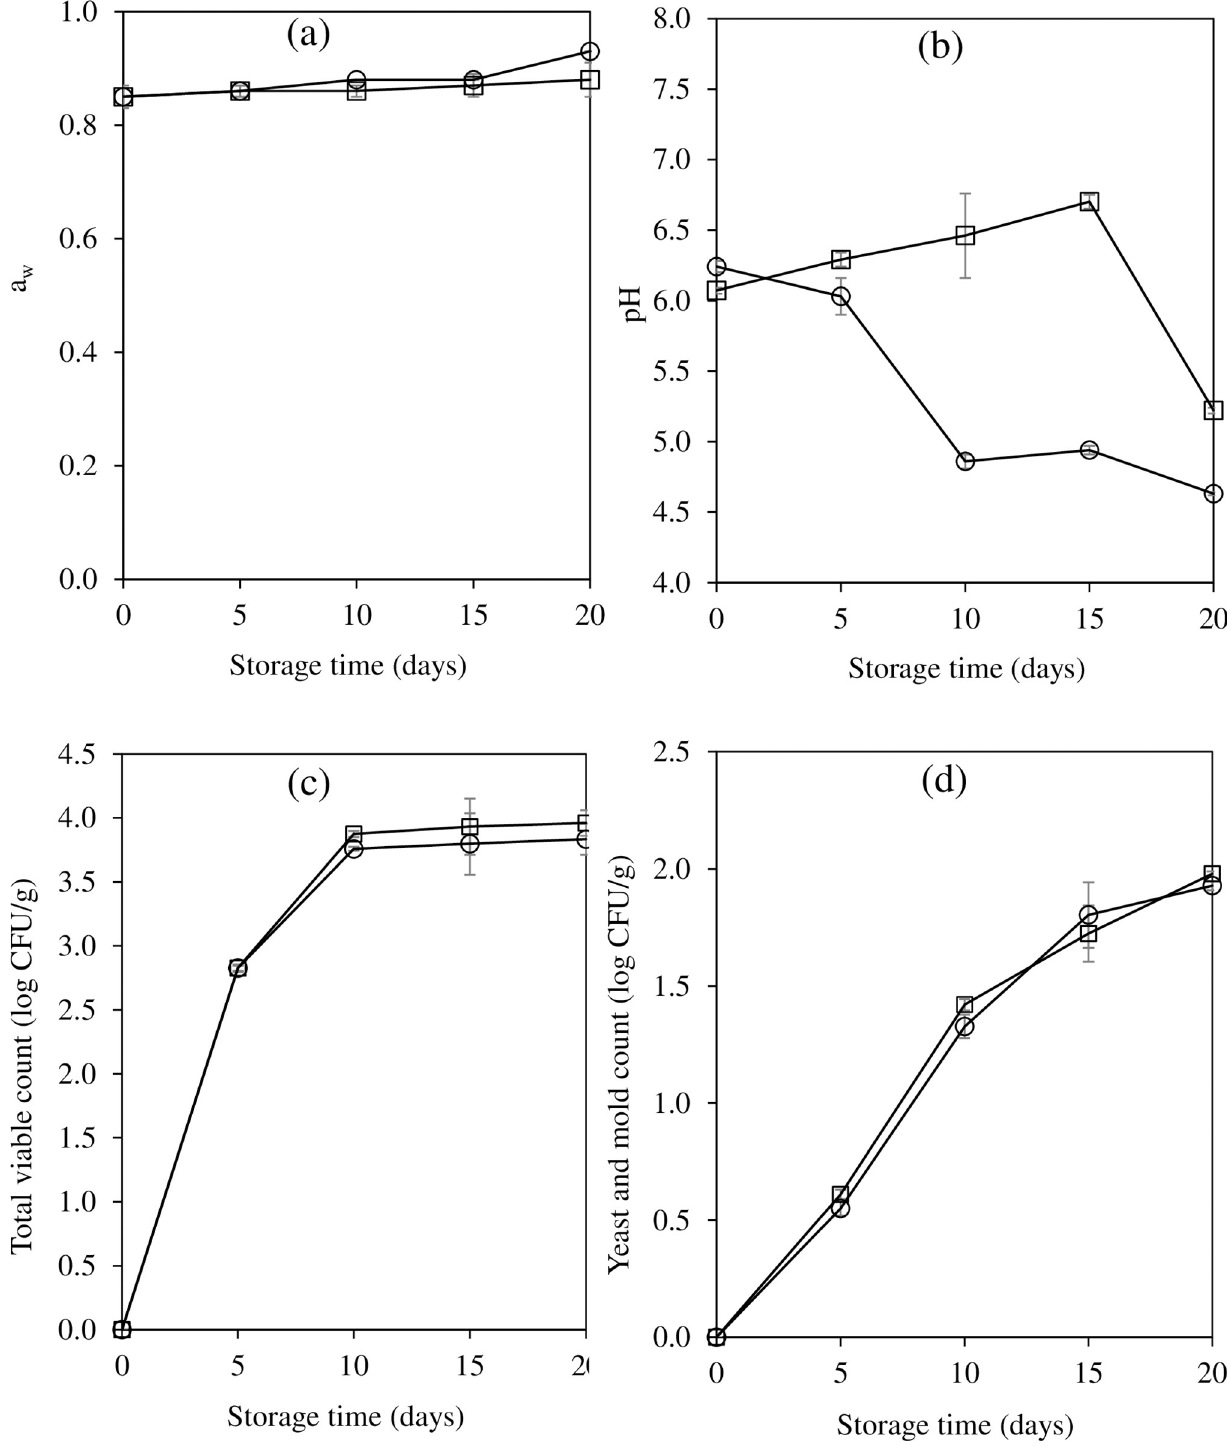
Fig 4. Changes in a w (a), pH (b), total viable count (TVC) (c), and yeast and mold count (d) of semi-dried Chinese style tilapia sausages formulated with pork back fat (control; � ) and carrageenan based emulgel ( □ ) during storage at room temperature.